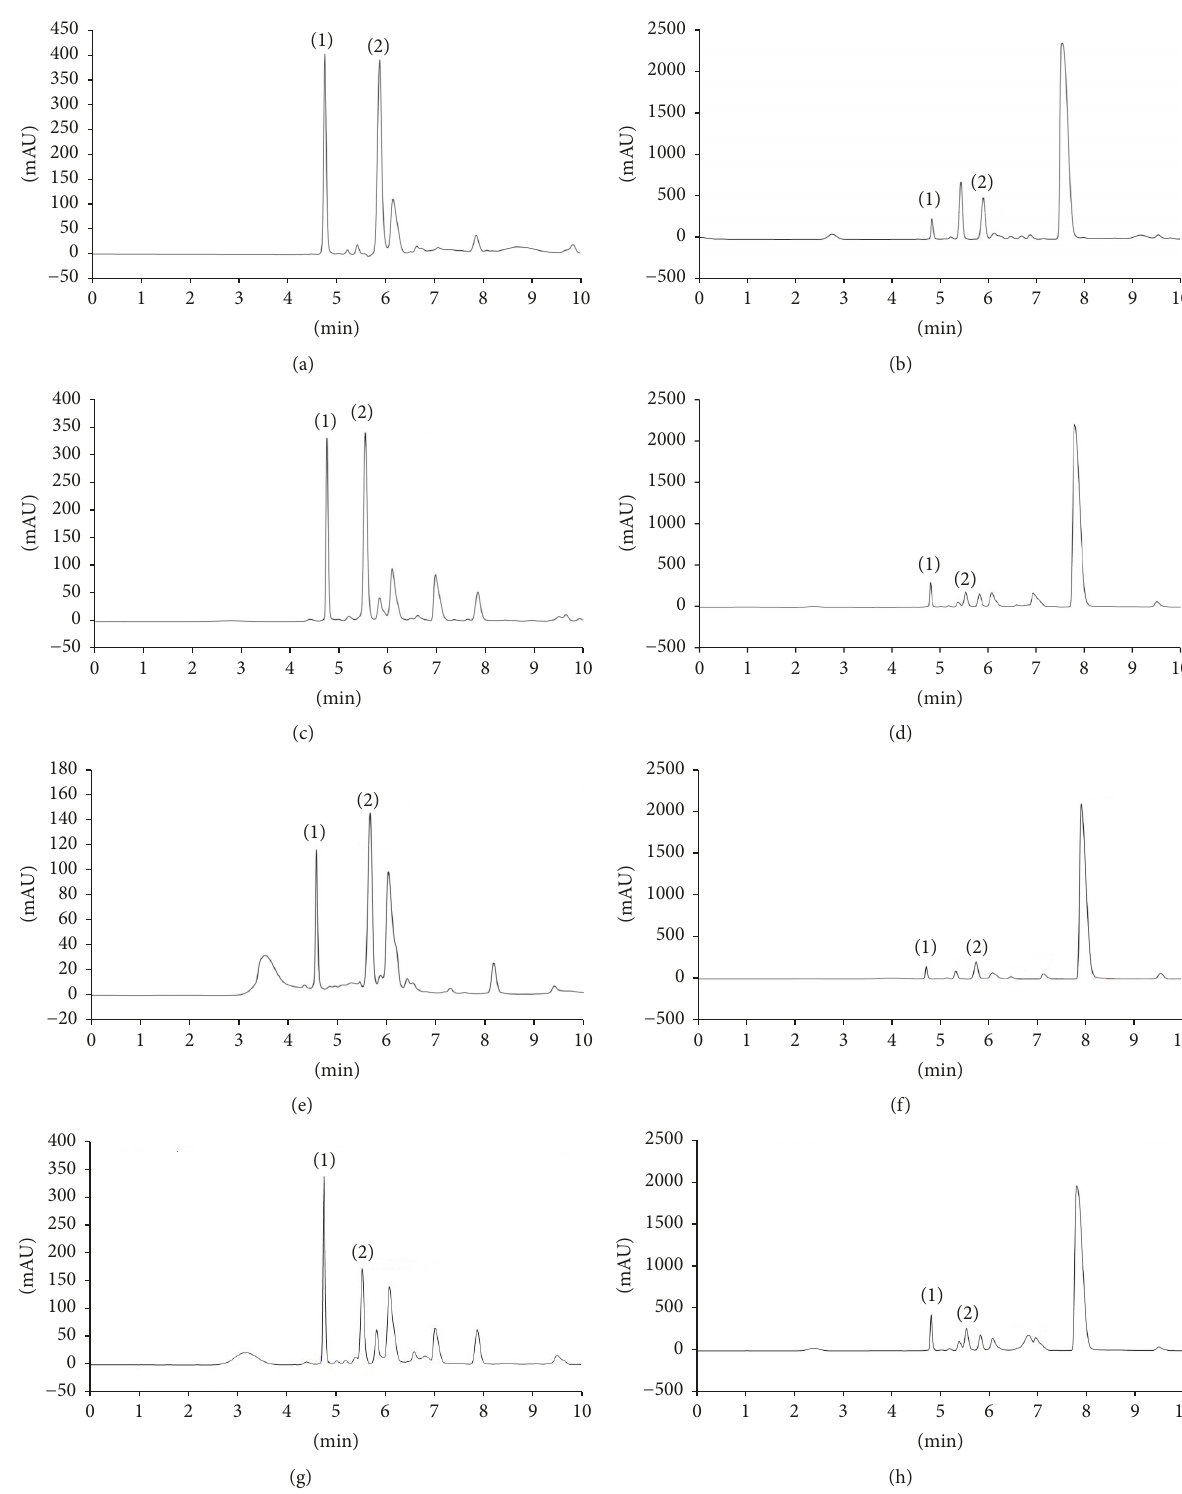
Figure 6: Comparative chromatographic profiles showing isocratic RP-HPLC separation of flesh and rind from juice extracts and methanol extracts of red watermelon and yellow crimson watermelon using Gemini C 18 . Red watermelon: (a) flesh juice extract, (b) rind juice extract, (c) crude flesh extract, and (d) crude rind extract. Yellow crimson watermelon: (e) flesh juice extract, (f) rind juice extract, (g) crude flesh extract, and (h) crude rind extract. The peaks marked represent (1) L-arginine and (2)